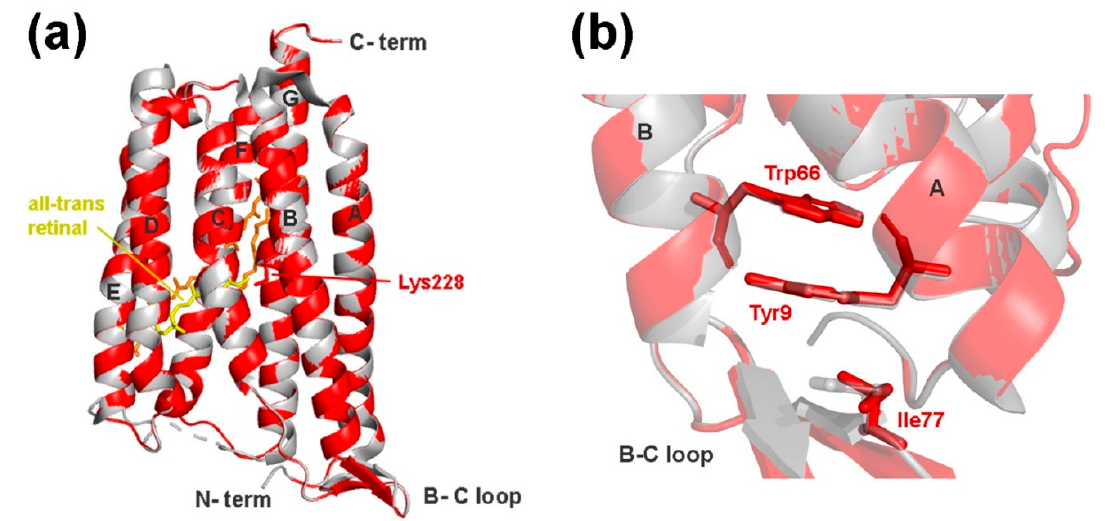
Figure 6. ( a ) Superimposed structures of Rba. sp. M37P xanthorhodopsin (RXR; red) and the Salinibacter ruber xanthorhodopsin (light gray, PDB entry 3DDL) The retinal and salinixanthin chromophores from XR are labeled in yellow and orange, respectively. ( b ) Detailed structural image of the 3-omega motif formed by pi-stacking of aromatic residues in helix A, B, and the B–C loop. RXR residues are labeled in red and Salinibacter XR residues shown in